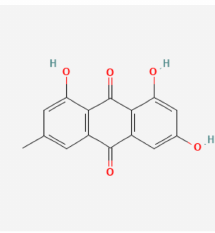
Figure 3. Chemical structure of Emodin Available on line https://pubchem.ncbi.nlm.nih.gov, (accessed on 10 December